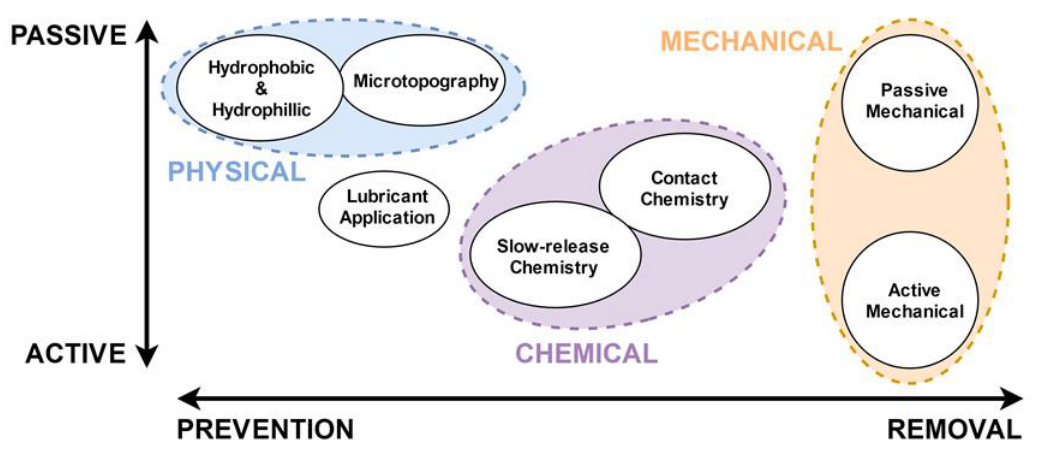
Figure 2. A generalised overview of some of the antifouling strategies that can involve biomimetic aspects or can be inspired by analogous strategies in the natural world. Different strategies can of course be combined, and indeed in many cases can perhaps lead to more efficient or effective fouling control.